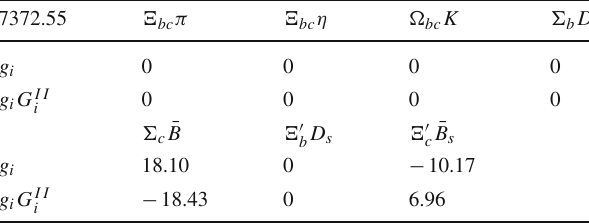
to various channels and g i G II in MeV with q max =